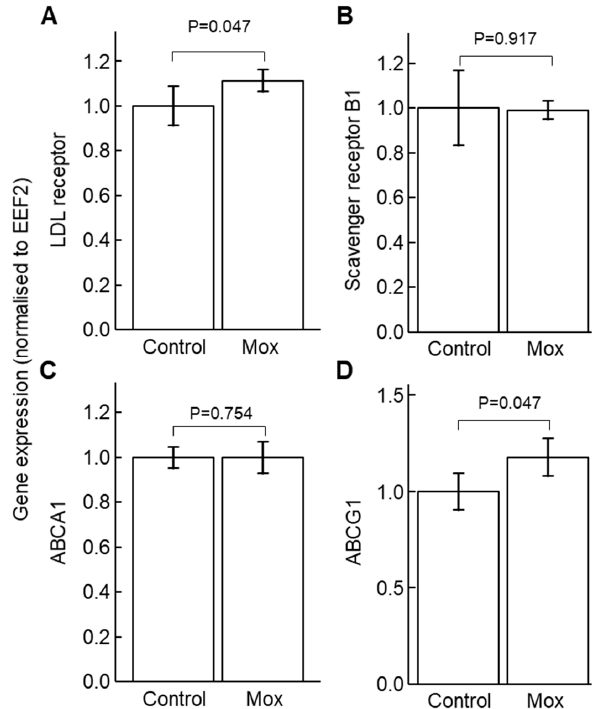
Figure 3. The effect of moxonidine on mRNA expression of genes related to lipid uptake and efflux. VSMCs were incubated with moxonidine (10 µM) or phosphate-buffered saline (PBS, control) for 2 h and the cells were then incubated with oxidised LDL (10 µg/L) for an additional 4 h. mRNA was extracted and the expressions of the LDL receptor ( A ), scavenger receptor B1 ( B ), ABCA1 ( C ) and ABCG1 ( D ) were quantified via quantitative PCR. The difference was analysed by Mann–Whitney U test. Data represent mean fold-change (vs. control) ± SD; N = 5. ABCA1, ATP binding cassette subfamily A member 1; ABCG1, ATP binding cassette subfamily G member 1; EEF2, eukaryotic elongation factor; LDL, low-density lipoprotein; Mox, moxonidine; VSMC, vascular smooth muscle cells.